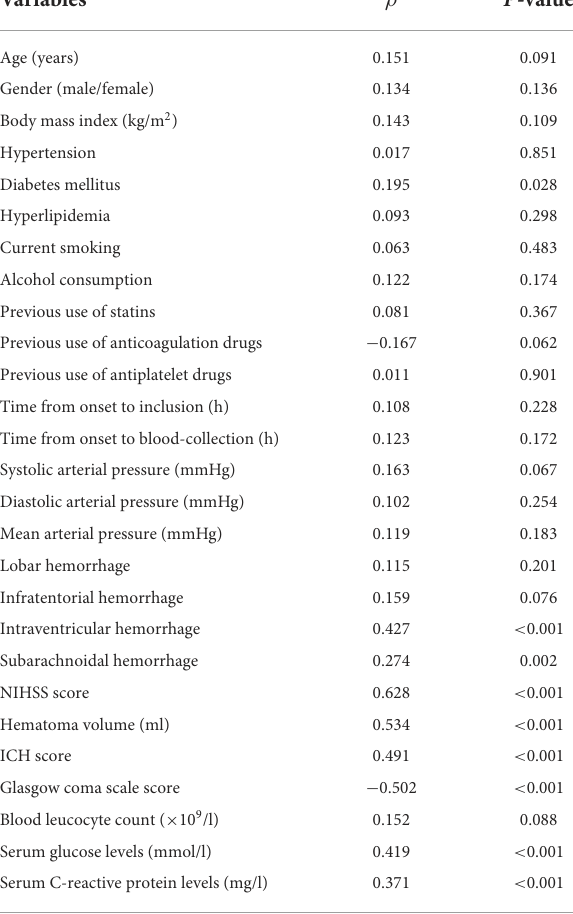
TABLE 1 Correlated factors of serum annexin A7 levels after acute intracerebral hemorrhage. Variables ρ P